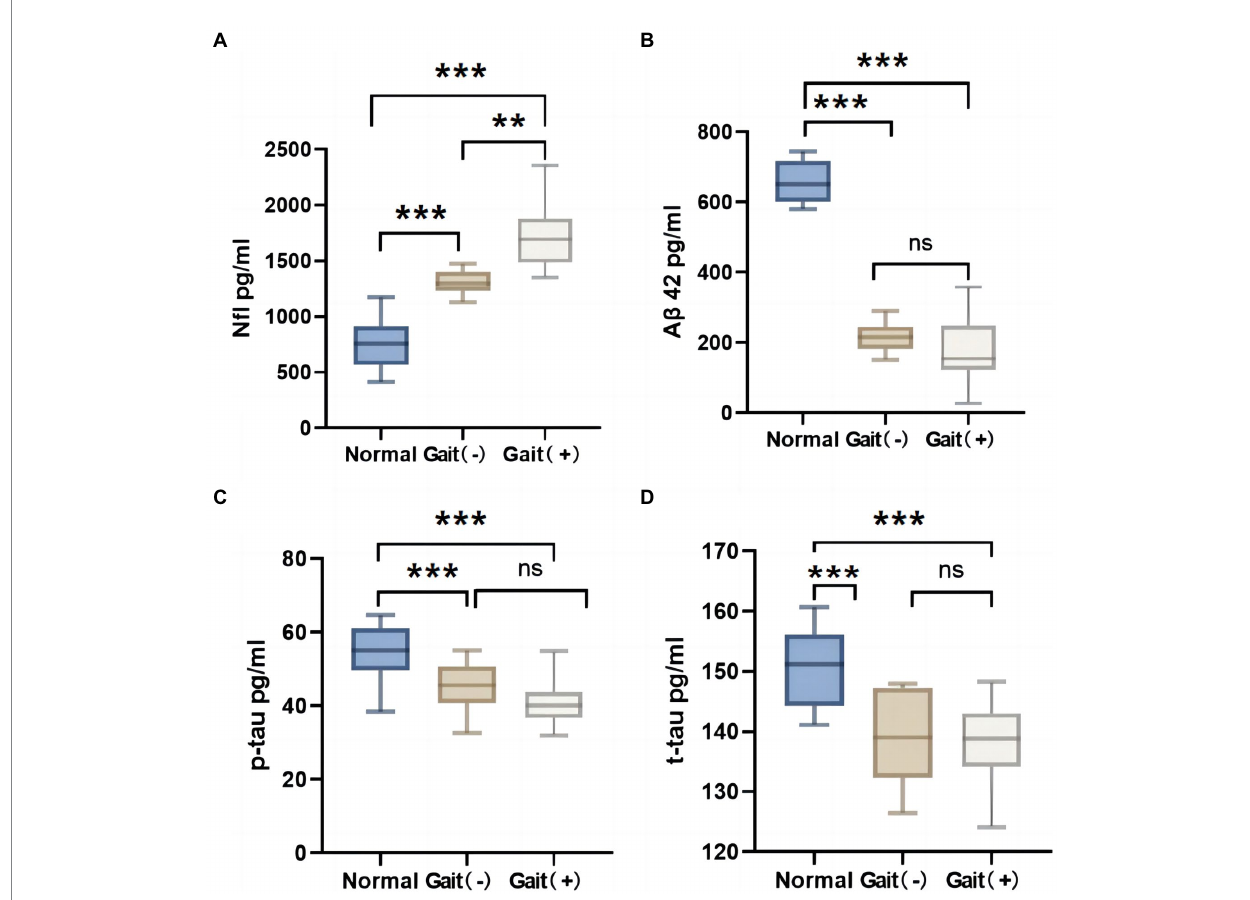
FIGURE 3 Difference of CSF markers in normal elderly, gait (+) group and gait ( − ) group. (A) Nfl in CSF of the gait (+) group was higher than that of the gait ( − ) group and the normal olders group. (B–D) A β 42, p-tau and t-tau in CSF of the gait (+) group were lower than those of the normal olders group. And there was no statistical difference between the gait (+) group and gait ( − ) group. *** p < 0.001, ** p < 0.01, and * p < 0.05. NfL, neurofilament